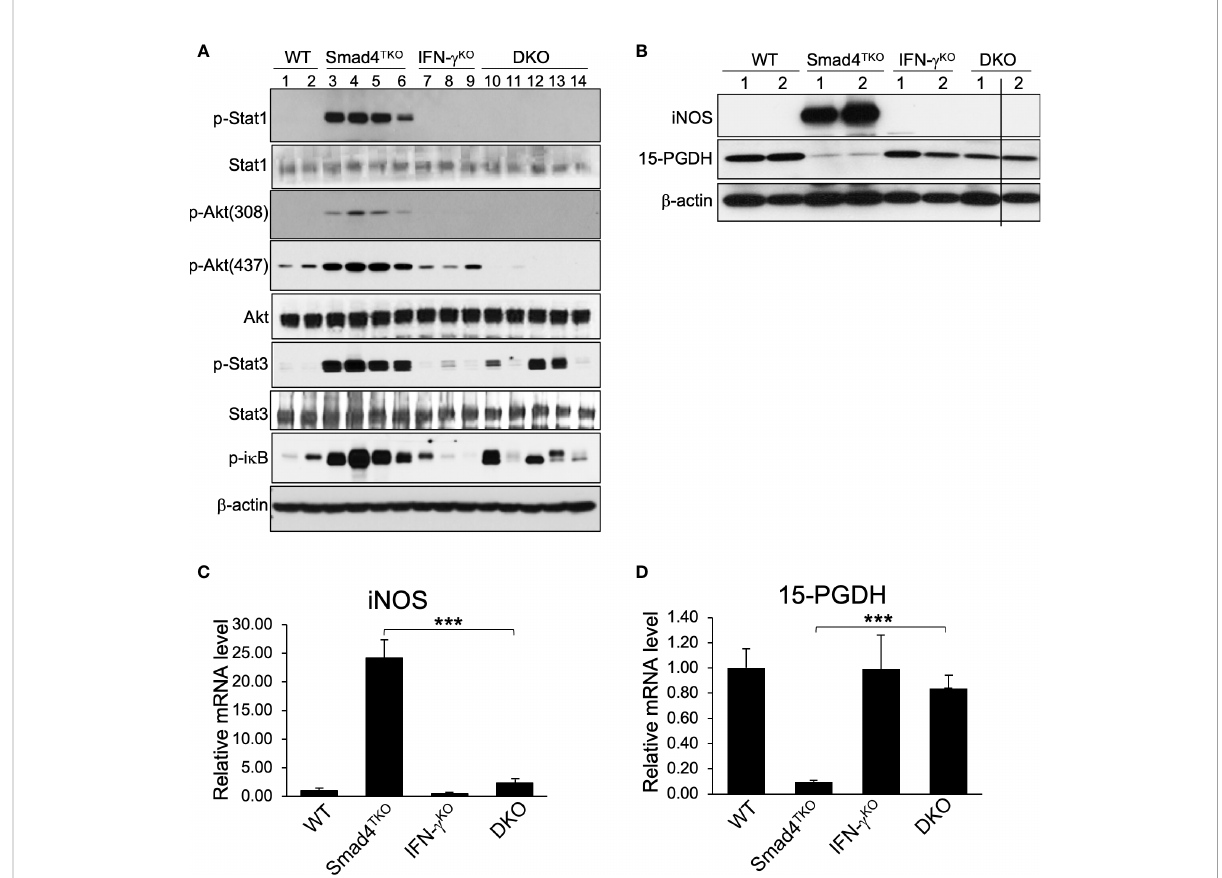
FIGURE 5 Deletion of IFN- g in Smad4 TKO mice inhibits in fl ammatory mediators and restores tumor suppressors in colon. (A) Protein expression of p-Stat1, Stat1, p-Akt(308), p-Akt(437), Akt p-Stat3, Stat3, p-ikb, and b -actin was measured by Western blot analysis of colon epithelial cell scrapings of each genotype. (B) Protein levels of iNOS, 15-PGDH and b -actin in colon of WT, Smad4 TKO , IFN- g KO and DKO mice. (C) Relative mRNA levels of iNOS and (D) 15-PGDH were measured by real time PCR in colon mucosa of WT, Smad4 TKO , IFN- g KO and DKO mice at 8 months of age (n=4-6). Error bars indicate S.E.; ***p <